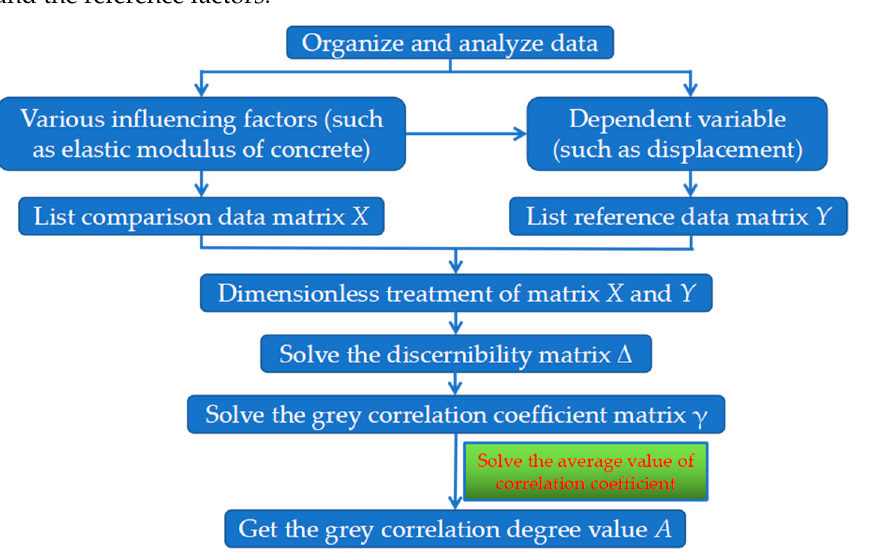
Figure 1. Flow chart of grey correlation analysis.